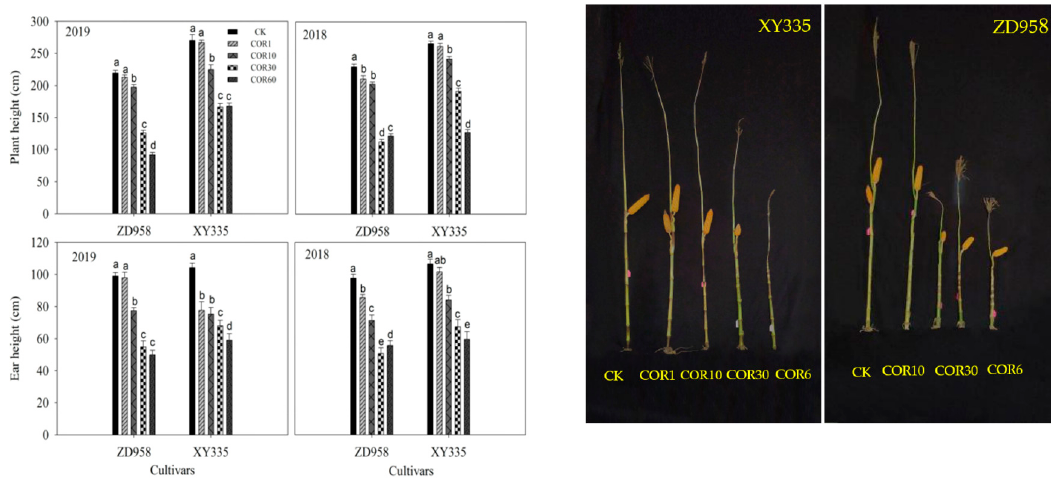
Figure 2. Effects of coronatine (COR) on maize plant height and ear height in field 2018 and 2019. ZD958: cultivar “Zhengdan958”; XY335: cultivar “Xanyu335”; CK: control treatment; COR1, COR10, COR30, and COR60 represent foliar application with coronatine at concentrations of 1, 10, 30, and 60 µM at the seventh-expanded-leaves stage, respectively.